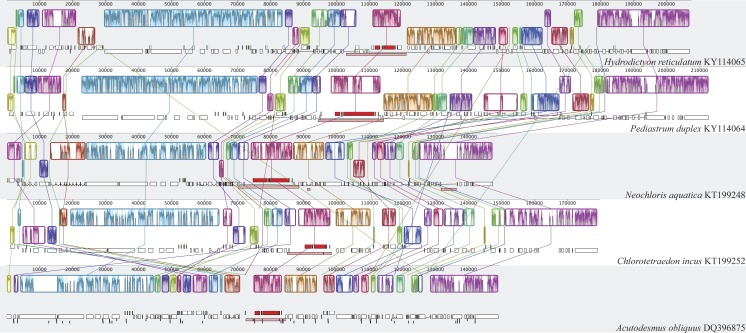
Synteny map of Hydrodictyaceae with Neochloridaceae and Acutodesmus obliquus.Blocks represent regions that align to a corresponding region in another genome and colored bars within each block indicate level of sequence similarity. Lines connecting blocks indicate putative homology.